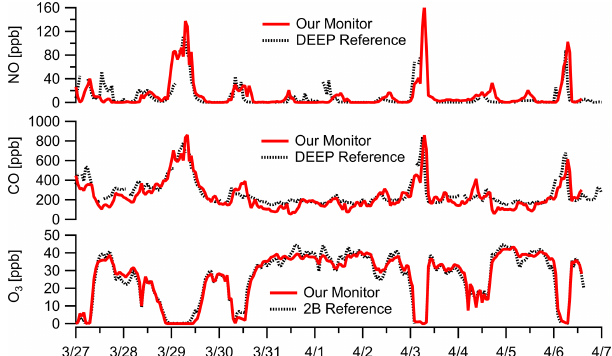
Figure 7. Ambient data at 1h resolution in New Haven, CT, near construction show large NO enhancements. The presence of NO is confirmed by both the titration of O 3 (i.e., NO + O 3 reaction) to zero and large enhancements in CO (a combustion co-pollutant). The near-road DEEP Criscuolo Park site (1.6km away from sam- pling location in downtown New Haven) is used for comparison. Note our NO sensor does not have significant cross-response to O 3 or CO. (See Fig. S11 for additional NO comparisons.) Multipollu- tant monitor data are corrected for RH– T where